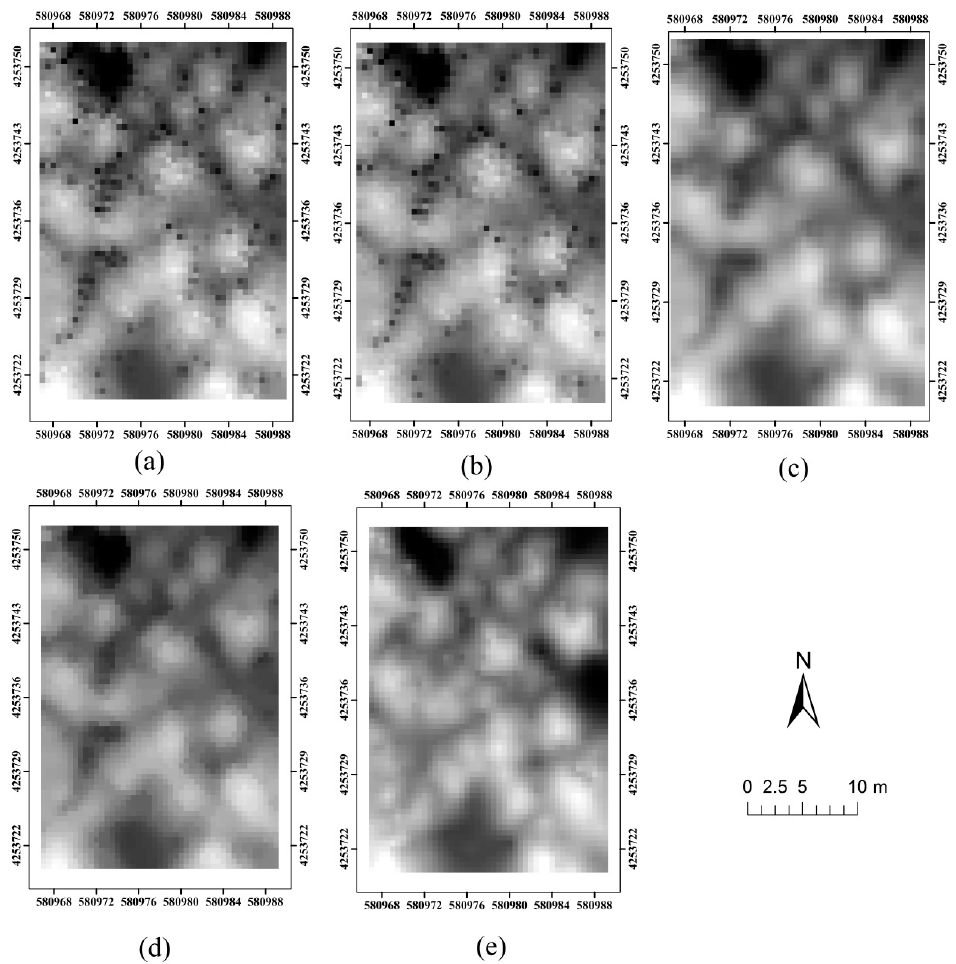
Figure 4. CHMs produced by ( a ) NN interpolation of raw light detection and ranging (lidar) points; ( b ) HPM; ( c ) mean filter; ( d ) median filter; and ( e ) our method.